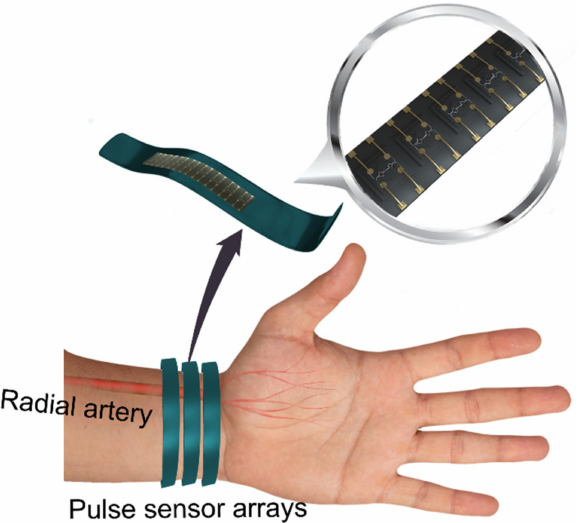
Figure 1. Flexible dense pressure-sensor arrays for three-dimensional arterial pulse signal